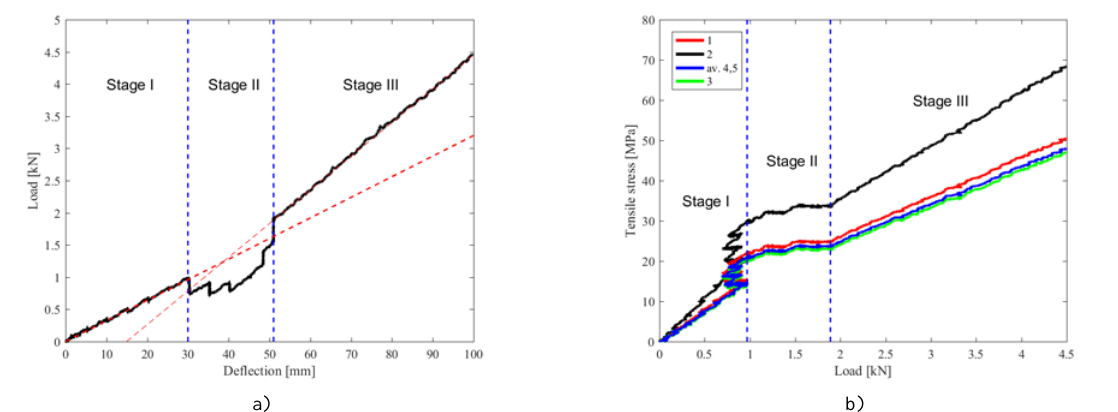
Fig. 2 Results of static loading test: a) Load-displacement plot, b) Load-tensile stress (in glass) plots at different locations of strain